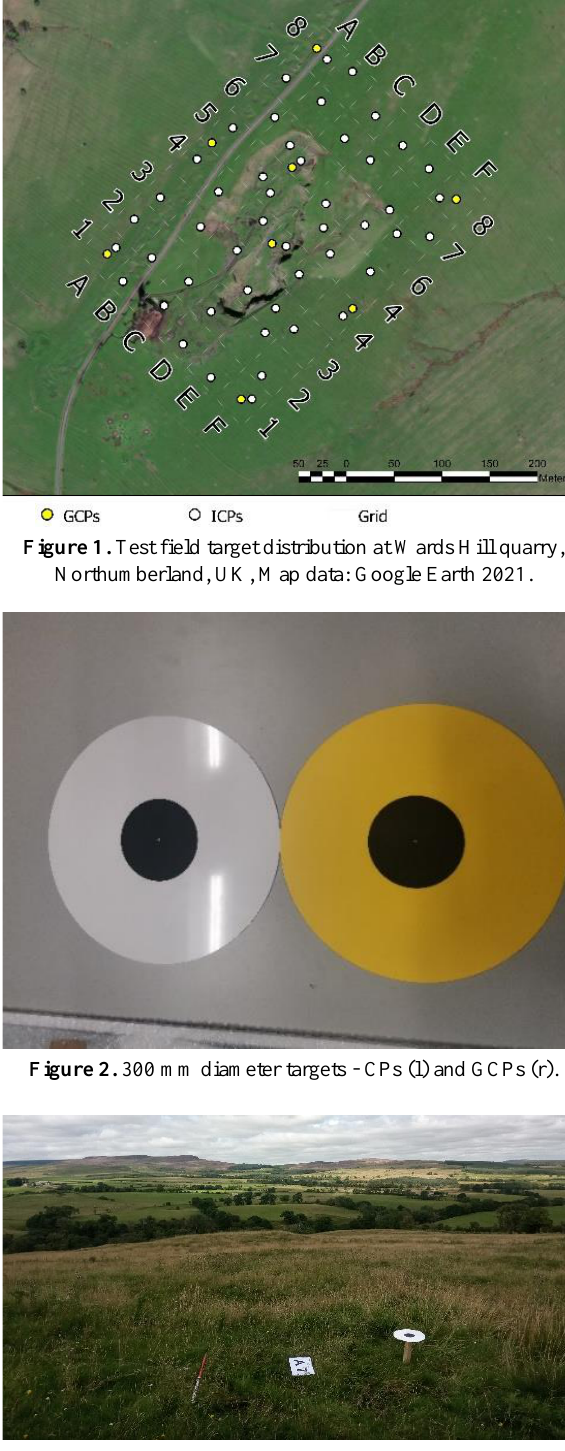
Figure 3. CP A7 located in the field and marked with a clipboard and ranging